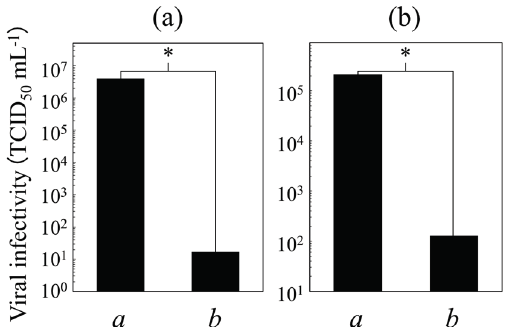
Figure 4. Anti-infection performance on (bars a ) non-coated and (bars b ) PGA/HDP-coated PET films against ( a ) Influenza A (H1N1, A/PR/8/34) and ( b ) B (B/Shanghai/361/2002) viruses. The viral infectivity was defined as a median tissue culture infectious dose (TCID 50 ) [10] per mL of the sample. Asterisks (*): the significance in virus inactivation on the assessment using the log reduction values (LRV)